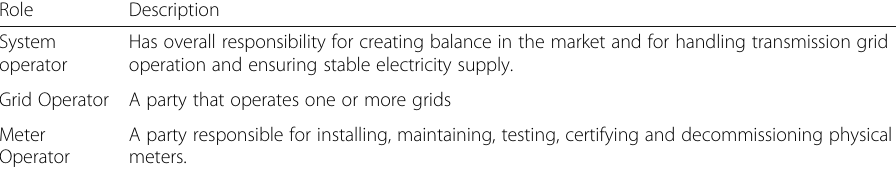
Table 10 An Example of the Roles and Descriptions in the Harmonized Role Model (E. a. e. ENTSO-E